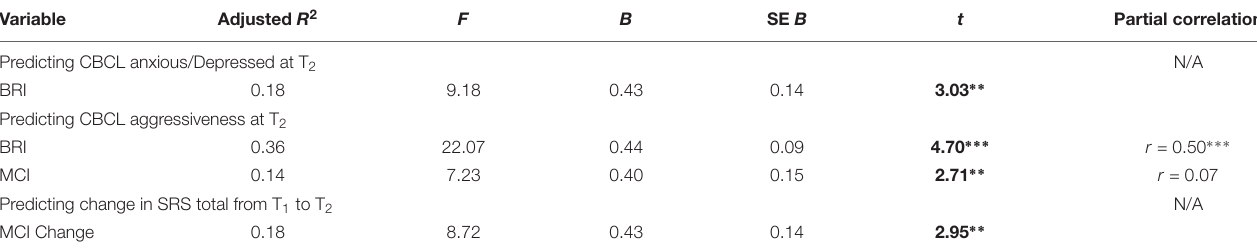
TABLE 3 | Simple univariate regression analyses in the ASD group: Influence of EF at T 1 on emotional/behavioral and social functioning at T 2 for children with ASD. Variable Partial correlation Predicting CBCL anxious/Depressed at T